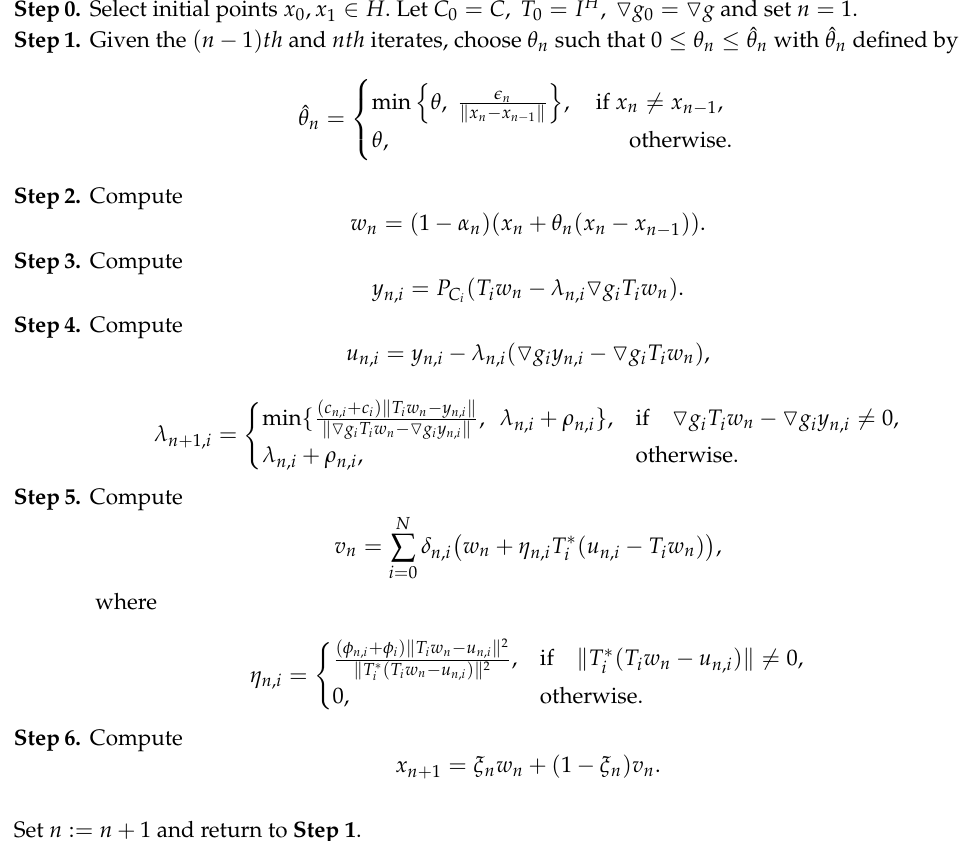
Algorithm 3. A Relaxed Inertial Tseng’s Extragradient Method for Solving SCMPMOS